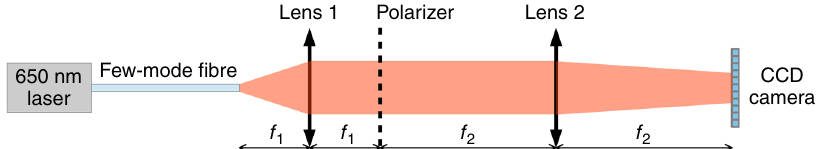
Fig. 7 Experimental set up. We used a 4-f imaging system to expose the near fi eld of the few-mode optical fi ber on a CCD camera for mode decomposition. A polarizer was used to select one polarization.